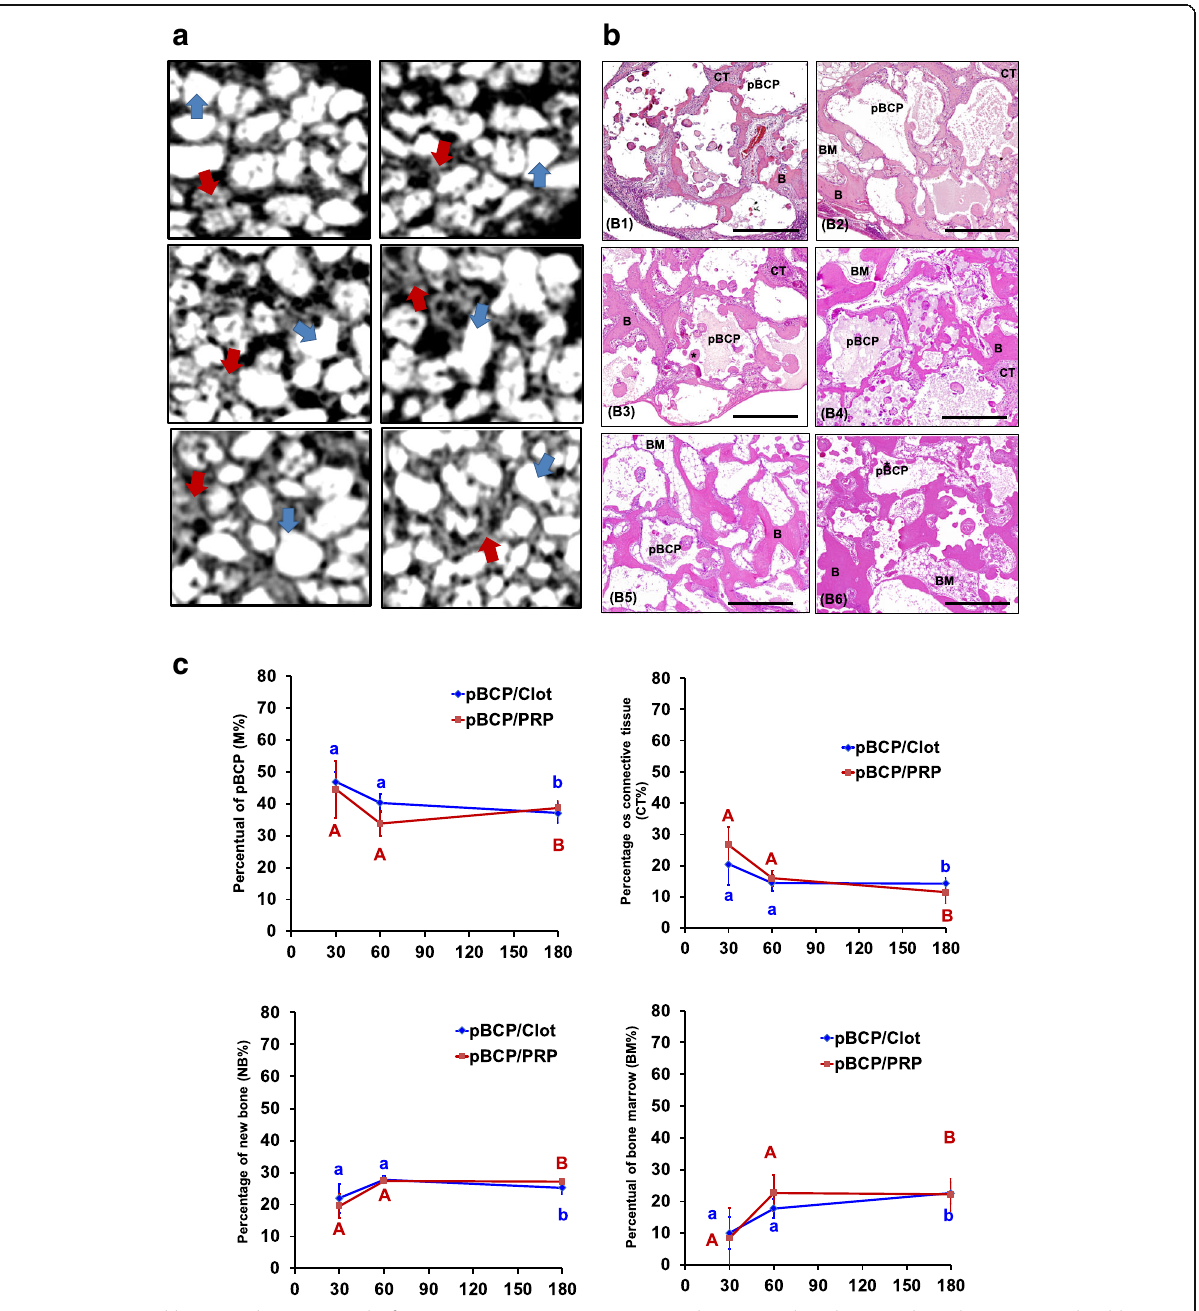
Fig. 5 Micro-CT and histomorphometric results for pBCP group. a 2D-Micro-CT view: the images show larger and regular pBCP particles (blue arrow) surrounded by new bone (yellow arrow) at 30 days. Between 30 and 180 days, the spaces were filled by bone. b Histologic view: at 30 days, the presence of large biomaterial (pBCP) particles (area surrounded by black dotted line) with bone (yellow arrow) formation occurring both on the surface and inside of the small pores and concavities of the particles, and connective tissue (CT) filling the remaining areas. At 60 days, the bone marrow (BM) gradually invaded the spaces between the particles, replacing the connective tissue and being more evident at 180 days. HE; 10×, c ) Percentage of each constituent: graphs of evolution of M% ( C1 ), CT% ( C2 ), NB% ( C3 ), and BM% ( C4 ) in MSA of pBCP/clot and pBCP/PRP. Different letters p < 0.05 among periods per